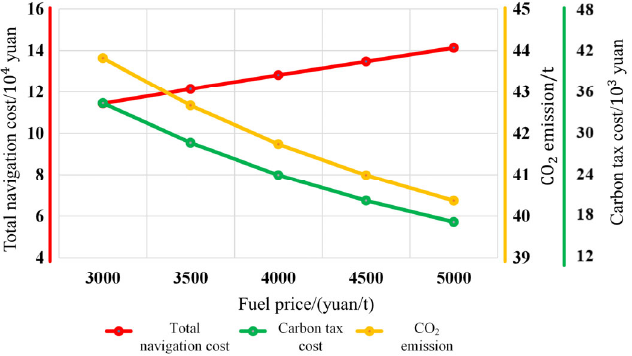
Figure 16. Total shipping costs, carbon tax costs, and CO 2 emissions at different fuel prices.